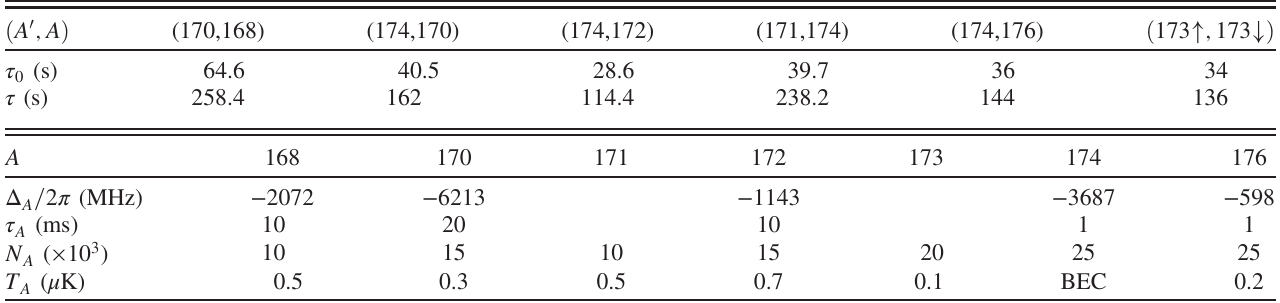
TABLE VII. Summary of isotope-dependent experimental parameters. The parameters Δ line from the 1 S 0 − 3 P 1 transition and the PA time for the isotope A , respectively. In addition, N atom before the interrogation and the atom temperature after the evaporative cooling, respectively. It is noted that the 174 Yb atoms are cooled below the transition temperature of the Bose-Einstein condensation (BEC) with no discernable thermal components. ð A 0 ; A